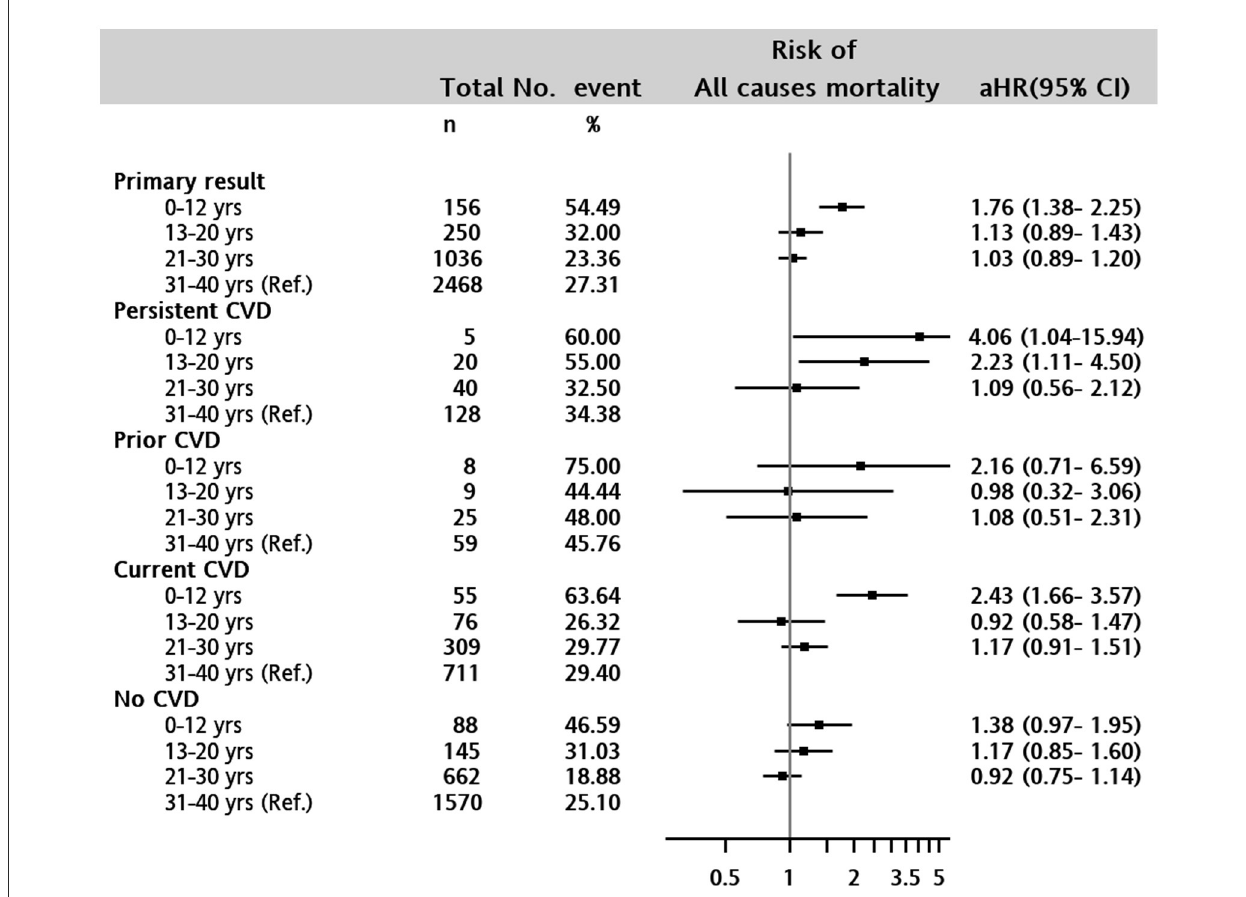
FIGURE3 Forest plot of adjusted hazard ratio for in-hospital mortality in 0–12 years, 13–20 years, 21–30 years, and 31–40 years (reference) of age groups. Persistent CVD: patients with any CVD both baseline and during the following covariates were adjusted for in the Cox proportional hazards model: Sex, type of CKD (CAKUT, non-CAKUT, and non-CKD), any congenital anomalies, baseline comorbid conditions of liver disease, severe liver disease, diabetes with and without complications, cancer, metastatic cancer, hypertension, hyperlipidemia, AKI diagnosis, and CVD at baseline and any time before death